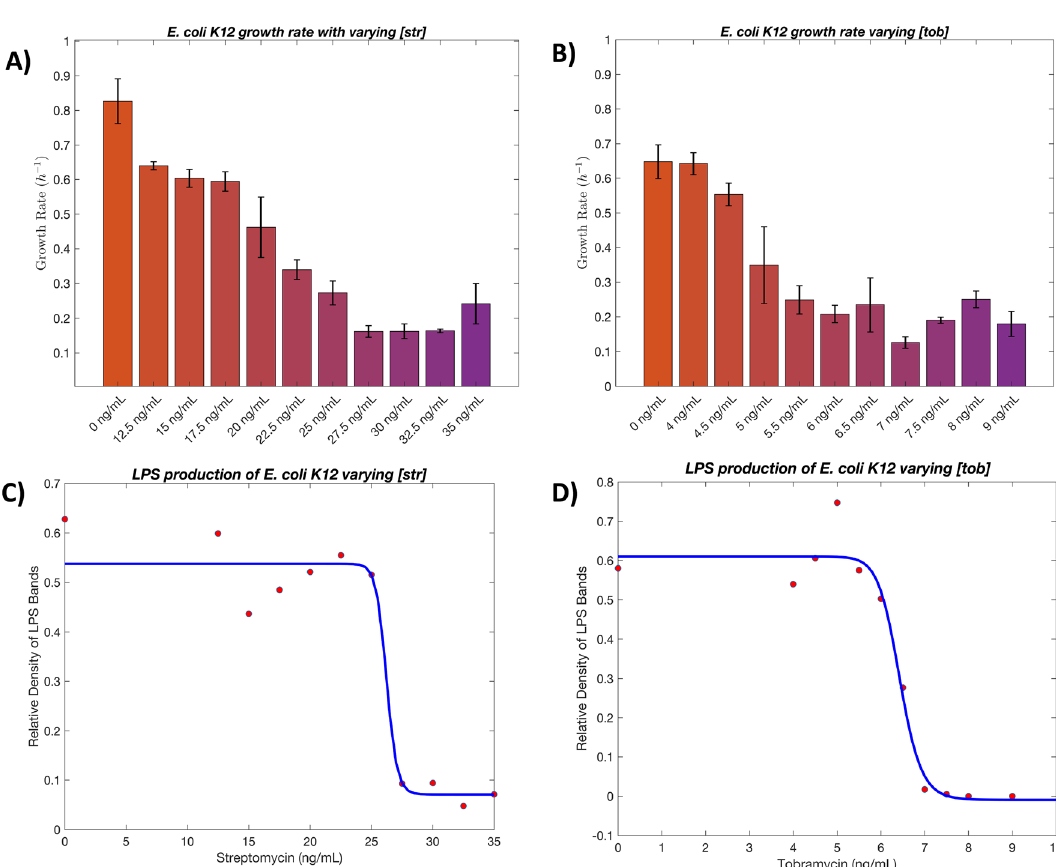
Figure 9. ( A ) and ( B ) Calculated growth rate in absorbance increase per hour as determined by the first derivative of a growth curve for streptomycin and tobramycin respectively. Samples from the growth assay are processed and ran on a polyacrylamide gel where the pixel density of LPS bands were determined over the various concentrations and plotted as sigmoid curves for streptomycin ( C ) and tobramycin ( D ). IC 50 values were determined from the inflection point of these fittings at 6.4 ± 0.1 and 26.2 ± 1.0 ng/mL for tobramycin and streptomycin